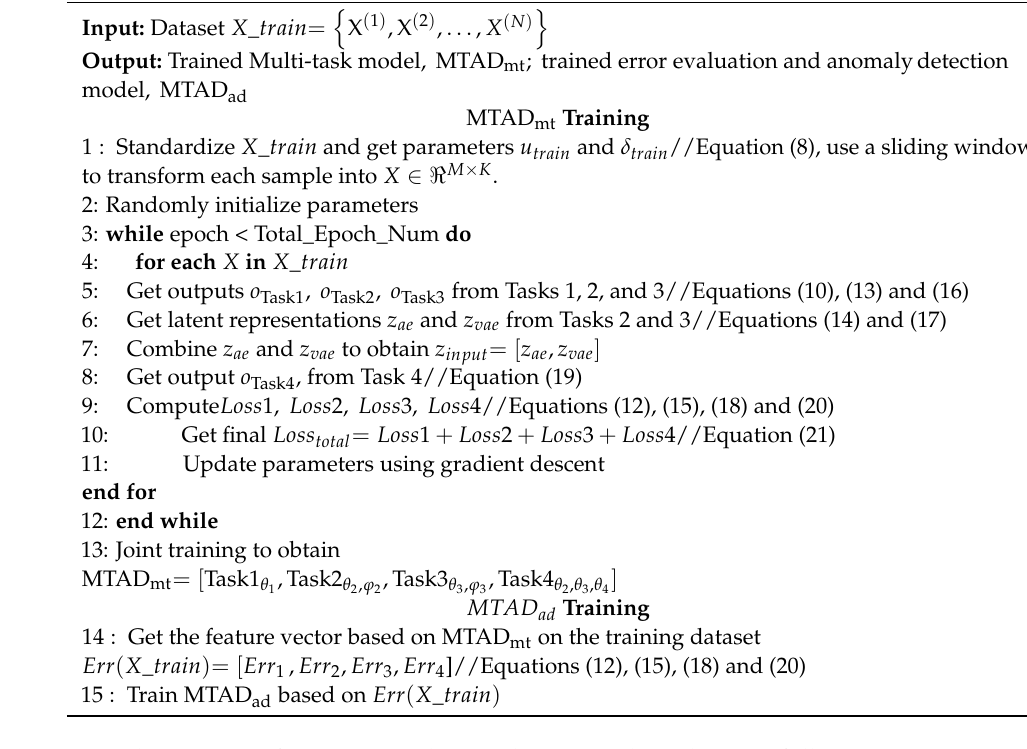
Algorithm 1: MTAD Training